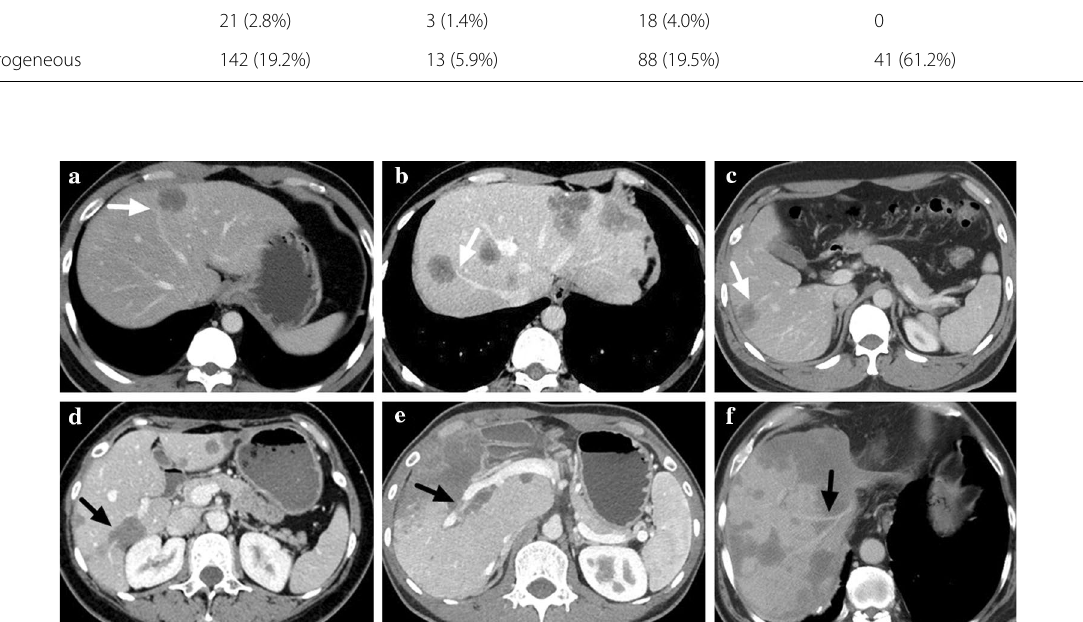
Fig. 3 a–c Lollipop sign on portal phase of three HEH patients, which showed vessels terminated at the edge of a well-defined lesion (marked with white arrows). d–f Vascular invasion on portal phase of three HEH patients, which showed vessels penetrated lesions or was surrounded by lesions with or without intact vessel structure (marked with black arrows)